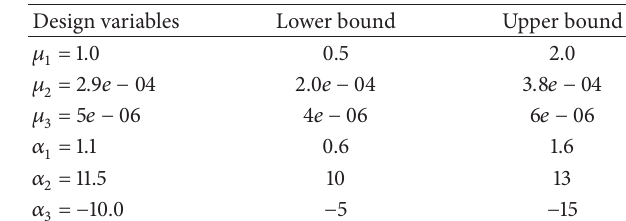
Table 1: The values of design